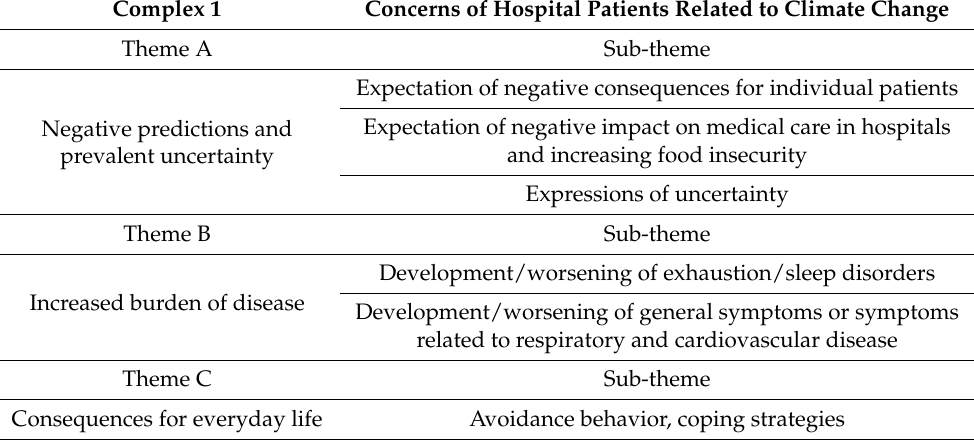
Table 2. Overview of themes emerging from the interviews grouped to complex